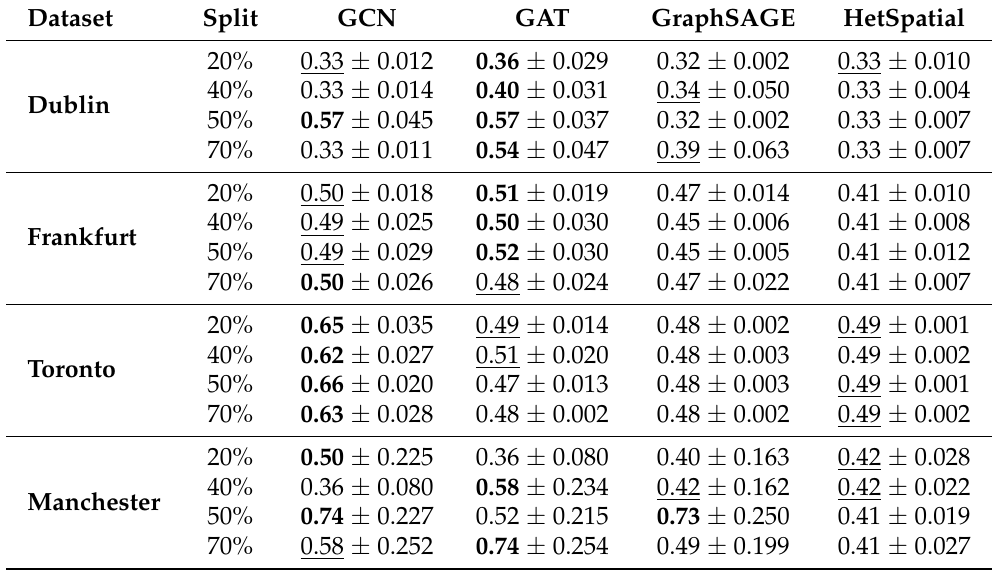
Table 4. Table showing the macro F1-score results for building type inference. The values in bold and underlined represent the best and second best performing approaches for each city/split, respectively.